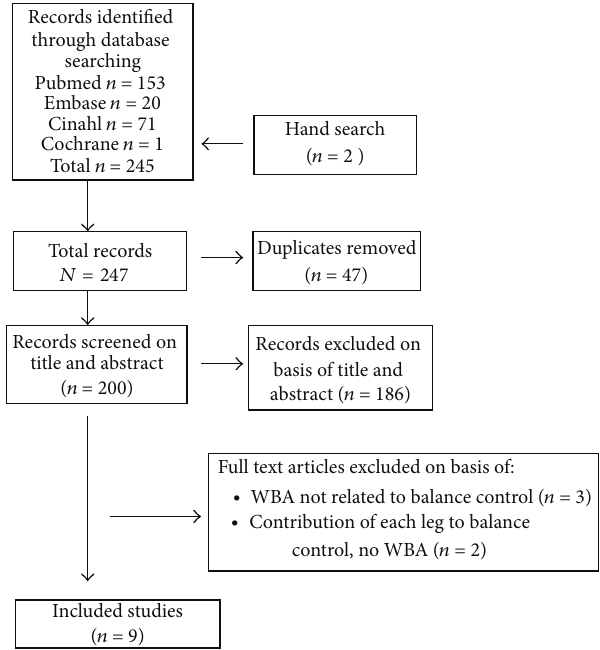
Figure 1: Flow chart of systematic review of weight-bearing asym- metry (WBA) related to postural